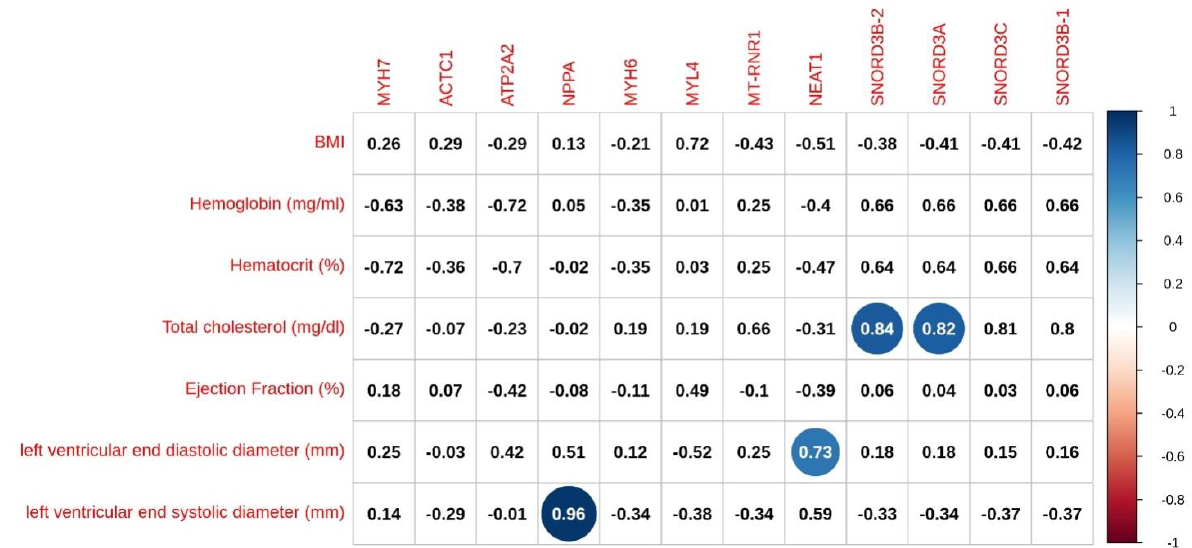
Figure 4. Quantitative real-time-polymerase chain reaction (qRT-PCR) analysis data for the top four most significantly target genes, such as protein coding genes ( MYH6 and NPPA ), mtRNA ( MT-RNR1 ), and lncRNA ( NEAT1 ), in DCM patients compared to HS. Three technical replicates were performed for each tissue sample. The relative expression levels are reported as the fold change derived from mean average of sample-specific Ct values.